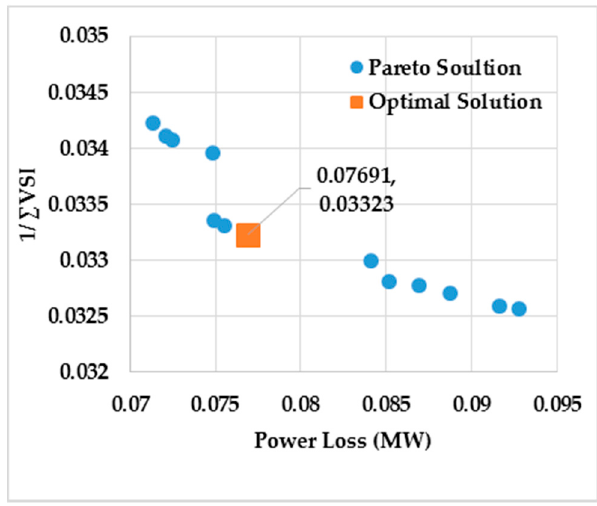
Figure 15. Pareto-solution and optimal compromise solution for Type-3 (1 DG). Table 8. Optimal compromise results of multi-objective function for Type-1 (2 DG) and Type-3 (1 DG).